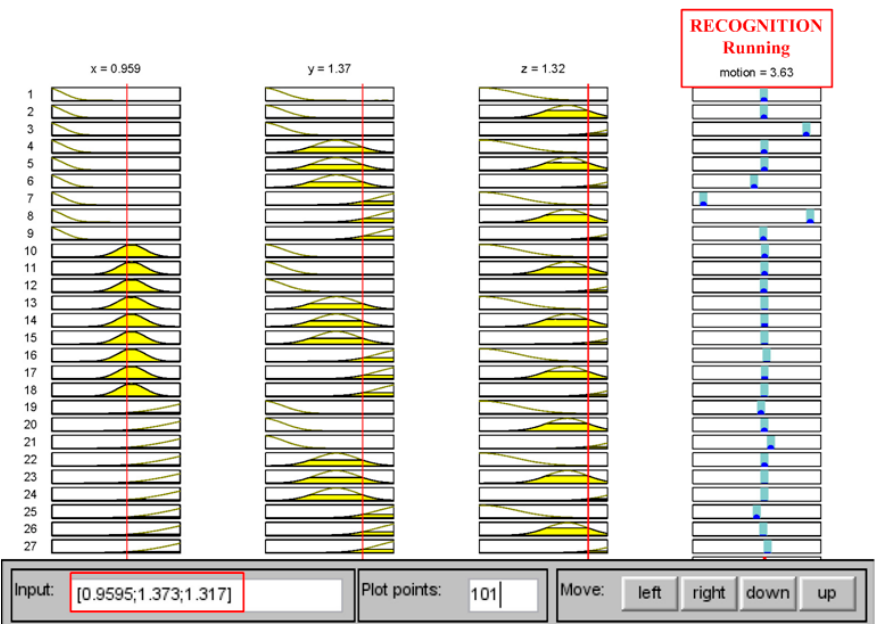
Figure 7. Recognition results from the trained FIS for the motions of walk and run, which are indexed within a range of [1, 2] and [3, 4], respectively.